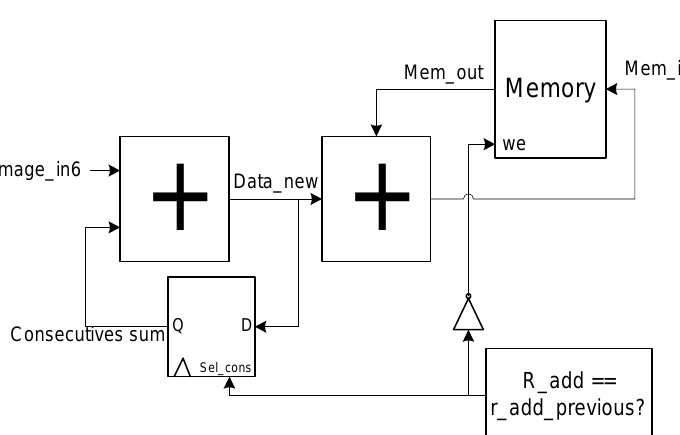
Figure 6. Diagram of the data